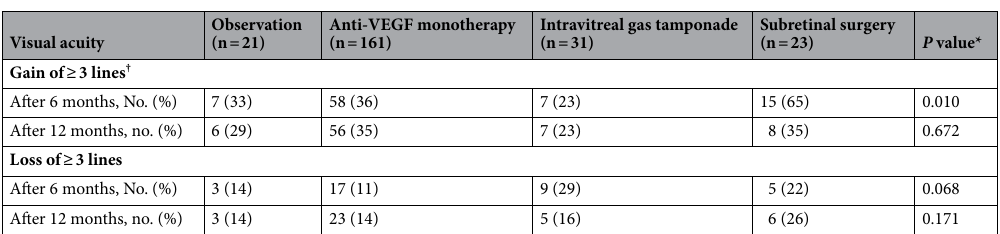
Table 2. Rates of loss or gain of visual acuity at 6 and 12 months after treatment for submacular hemorrhage in neovascular age-related macular degeneration. VEGF, vascular endothelial growth factor; t-PA, tissue plasminogen activator; LogMAR, logarithm of the minimum angle of resolution. *Chi-square test. † 3 lines = 0.3 LogMAR = EDTRS 15 letters.